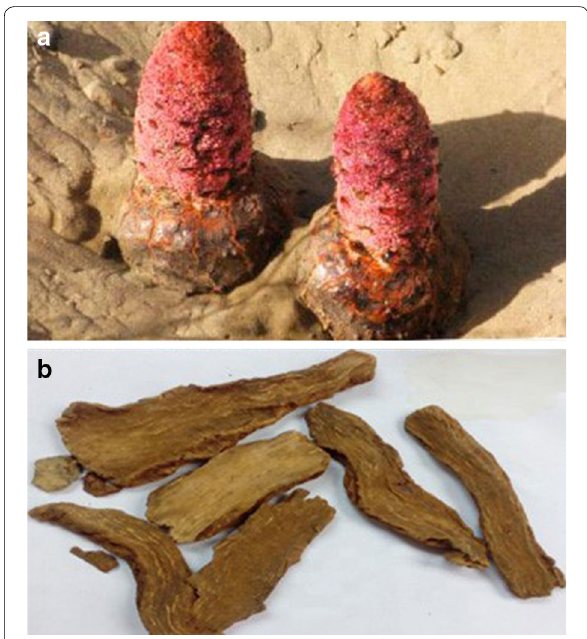
Fig. 1 Photos of Cynomorium songaricum Rupr ( a ) and Suoyang ( b